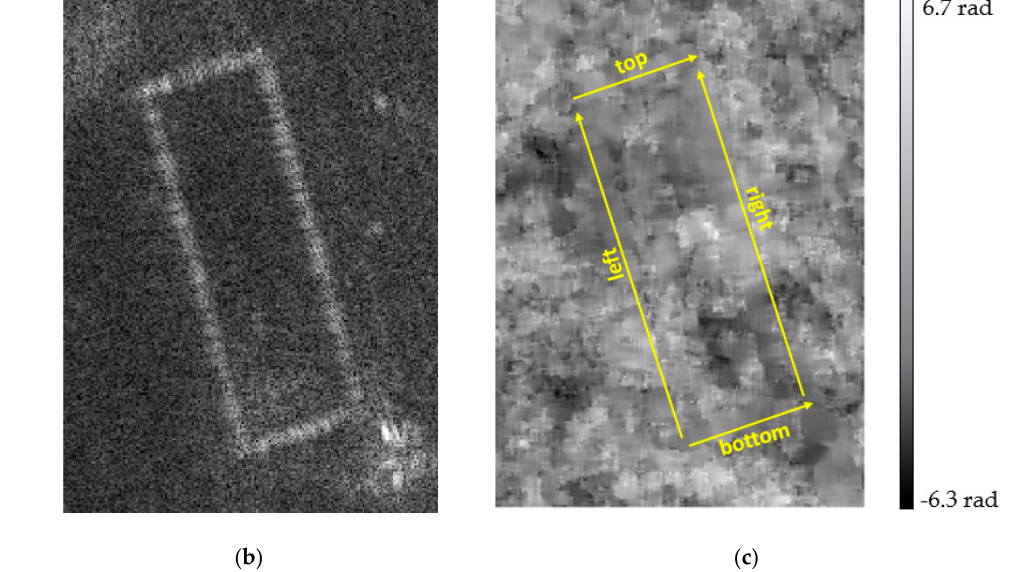
Figure 13. ( a ) Optical image of the metal fence; ( b ) radar image of the metal fence; and ( c ) unwrapped interferogram corresponding to the metal fence.